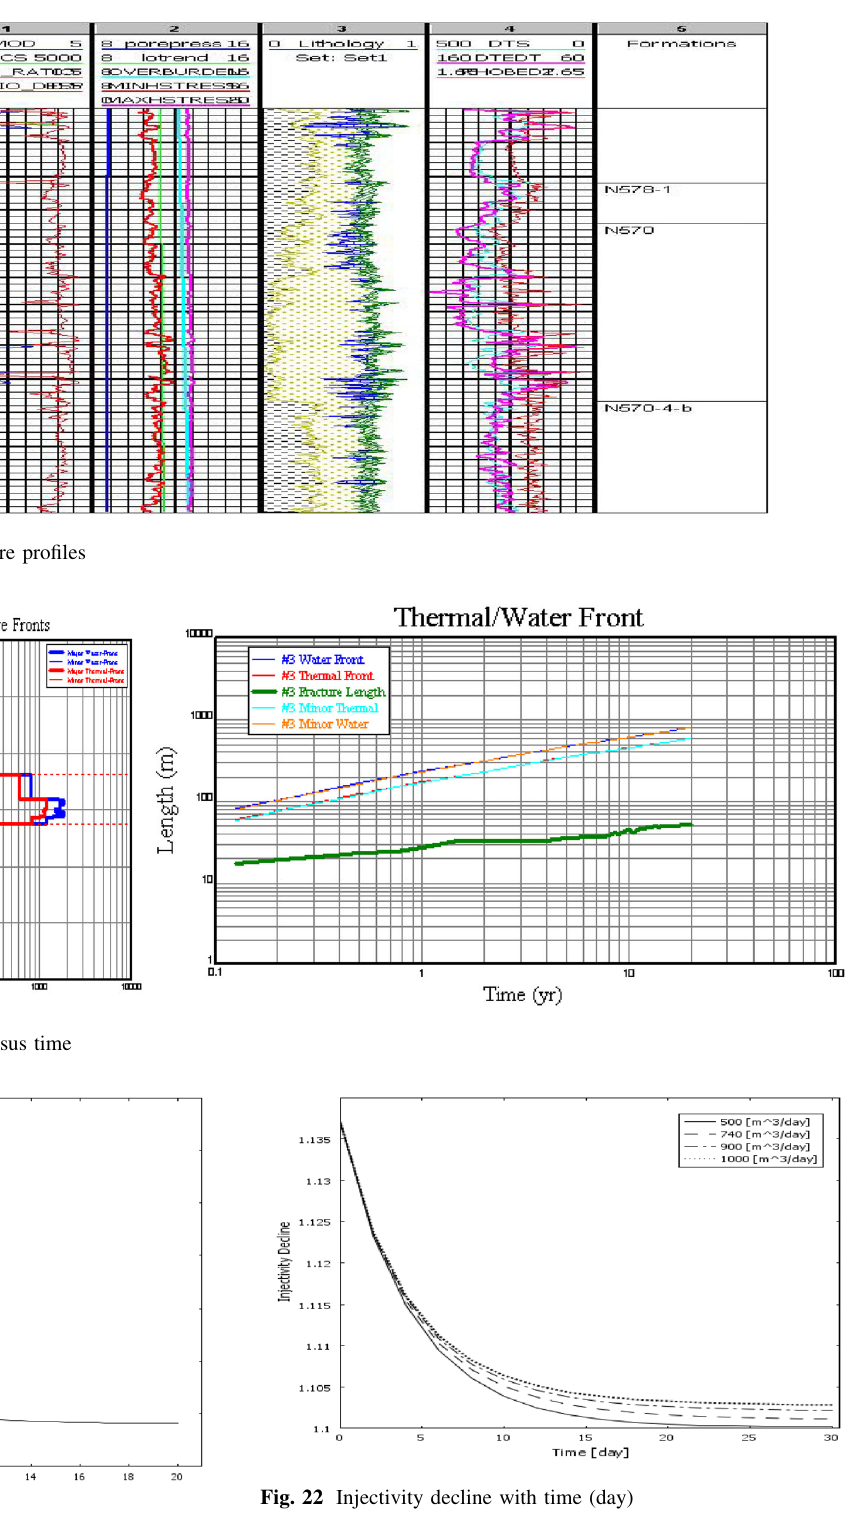
Fig. 21 Injectivity decline with damage factor